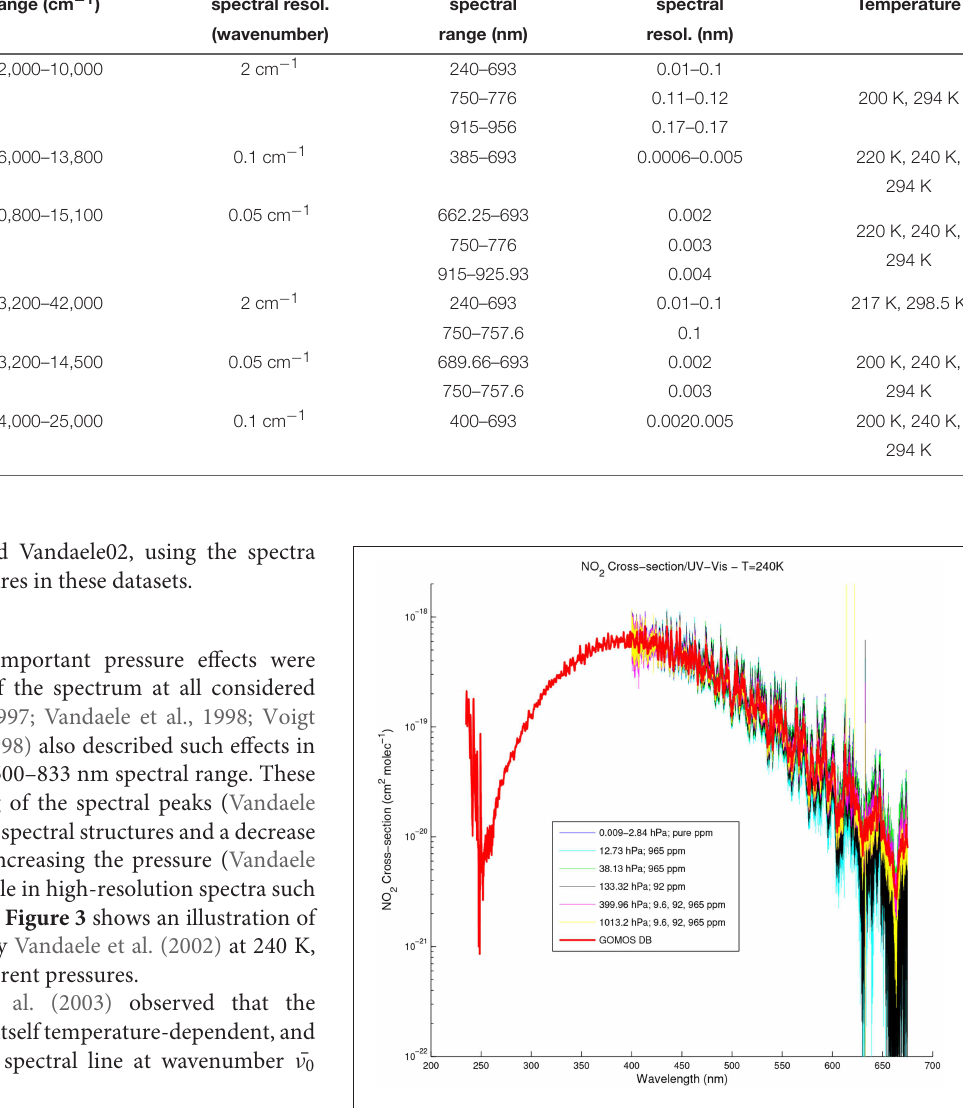
FIGURE 3 | NO 2 absorption cross-section between 245 and 695 nm at 240 K, observed by Vandaele et al. (2002) at different pressures. The NO 2 absorption cross-section spectrum from GOMOS DB is plotted in red for